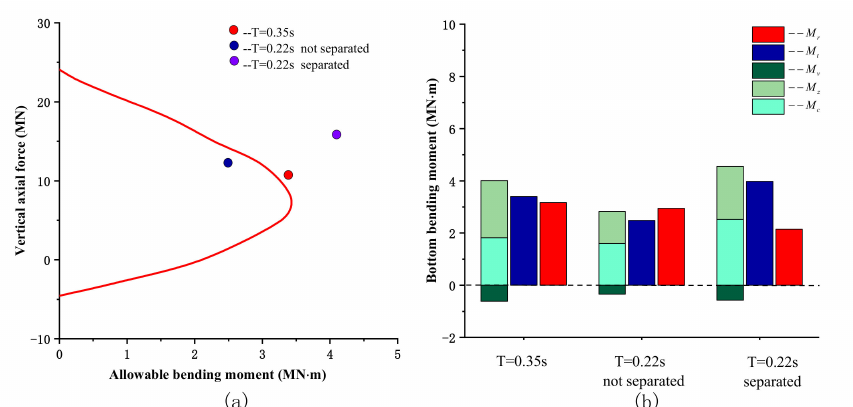
Figure 8. Bending moment at the base of the pier: ( a ) total bending moment and allowable bending moment of the base of the pier during two periods; and ( b ) the direction and magnitude of various bending moments at the base of the